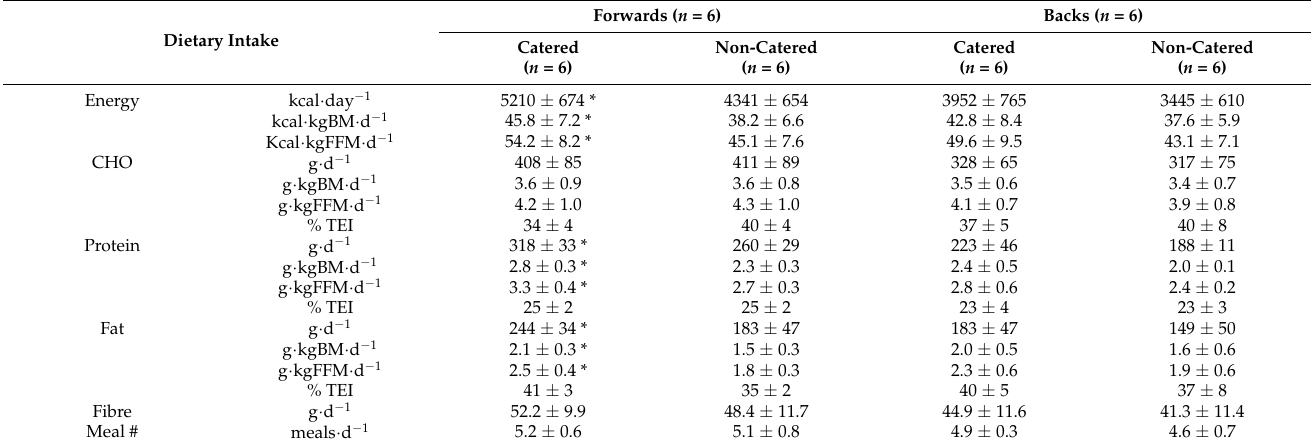
Table 3. Mean seven-day dietary intakes among catered and non-catered forwards and